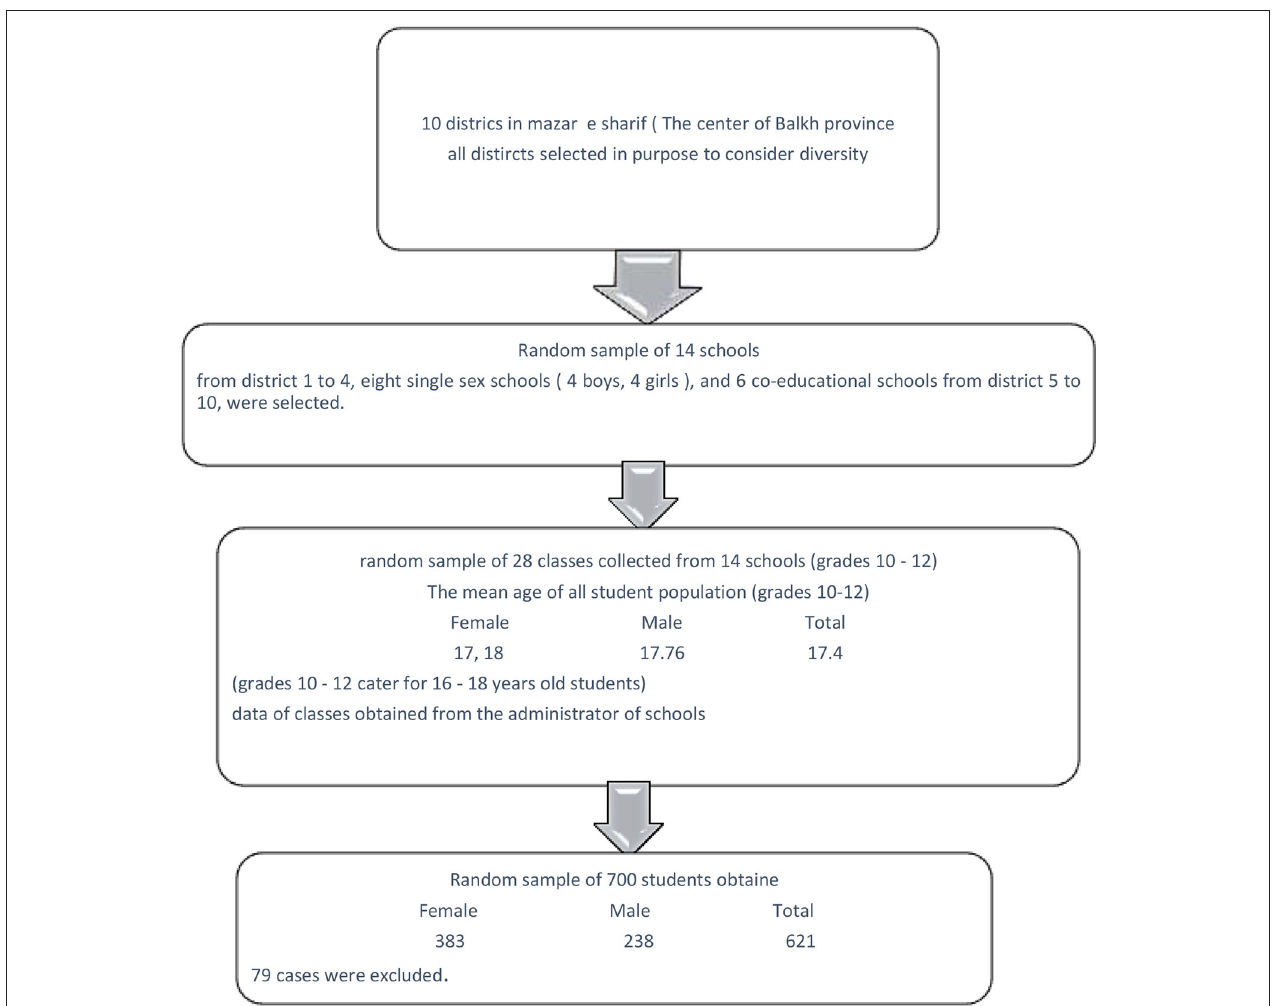
FIGURE 1 | Sampling for a three stage, stratified random